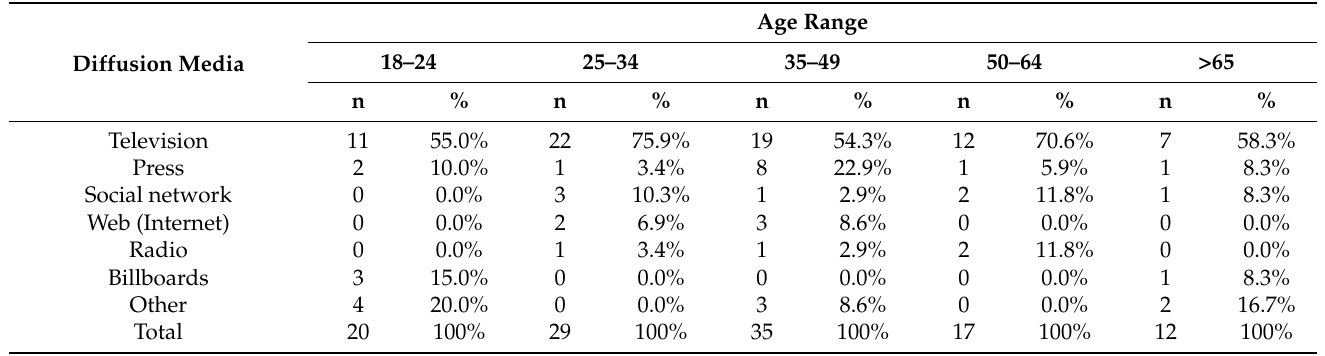
Table 4. Media issuing the traffic campaigns remembered, depending on the age group.